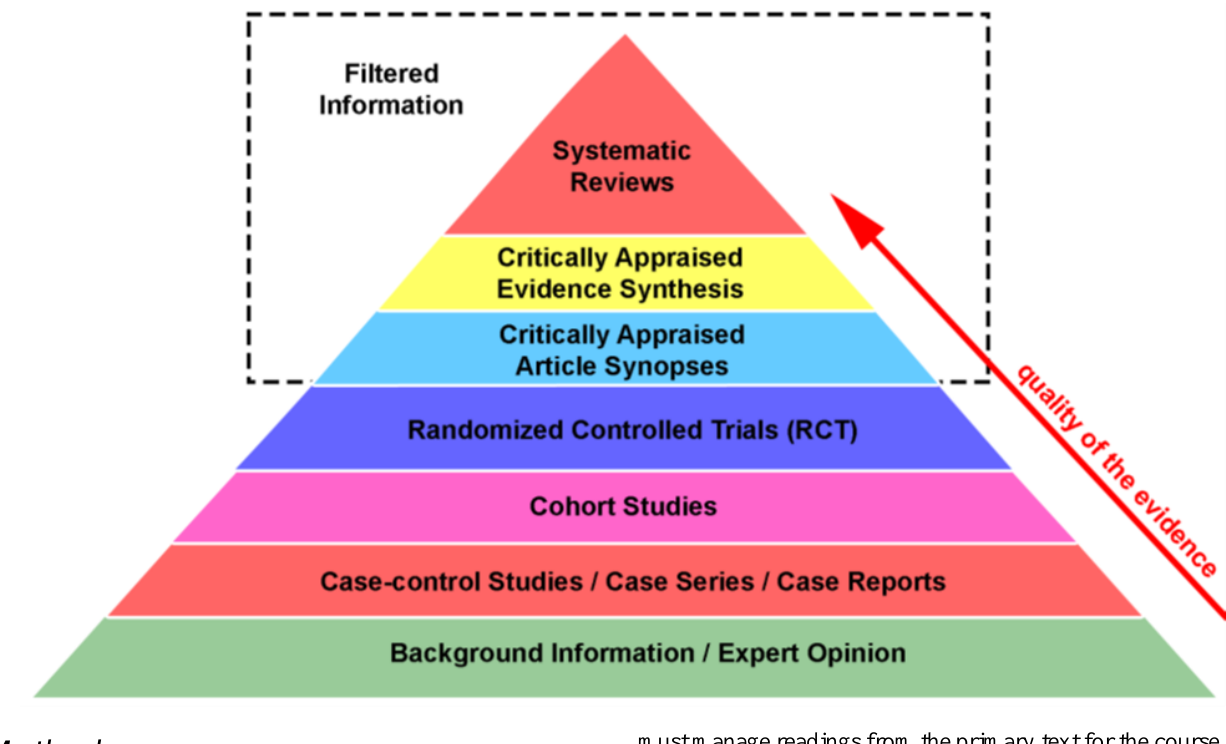
Figure 1. Levels of evidence analyzed in a systematic